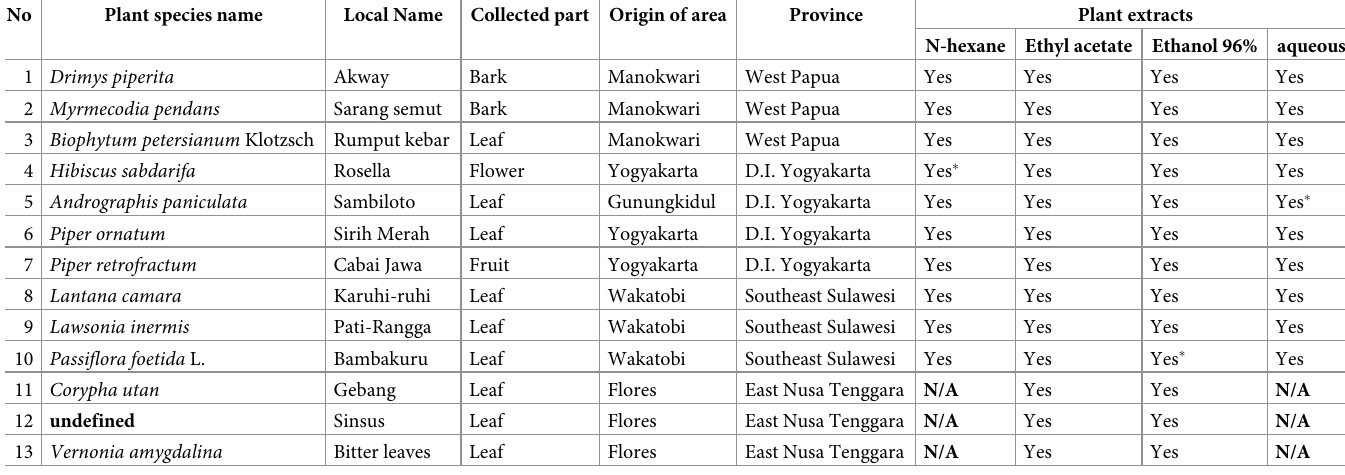
Table 1. Medicinal plants used by local citizen in Manokwari, Flores, Wakatobi, Gunungkidul and